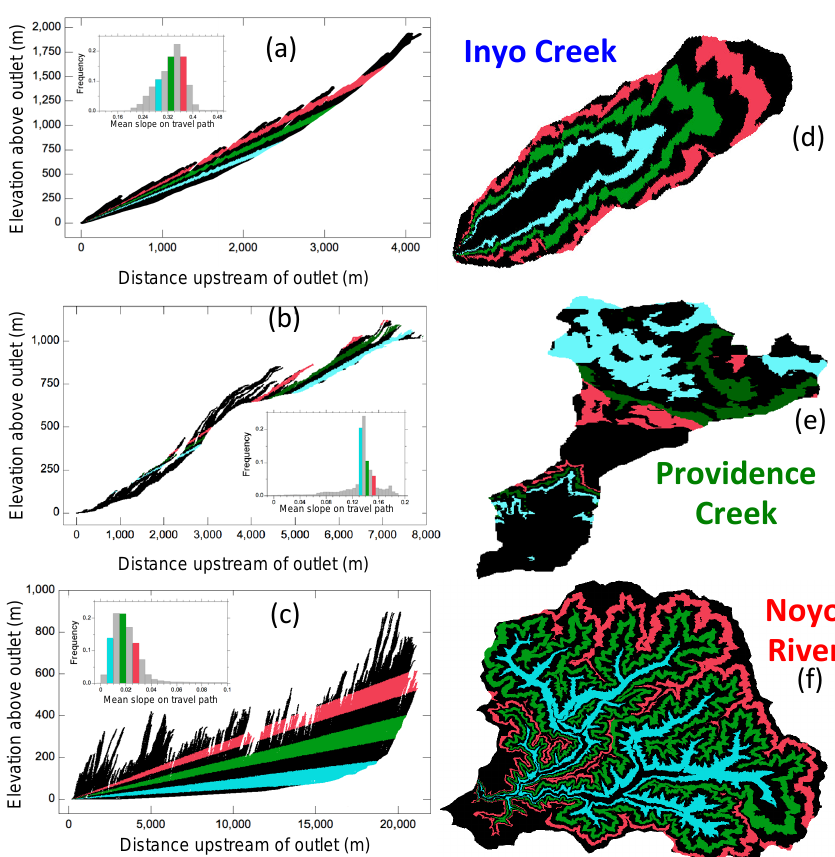
Figure 5. Distribution of mean slope across catchments. Histograms (insets, a–c ) of mean slope along travel path from source to outlet (ratio of source-area elevation to travel distance), with colors highlighting bins of relatively low, medium, and high values. Bins of common mean slope form linear bands on plots of elevation vs. travel distance ( a–c ). Maps of catchments ( d–f ) show spatial distribution of source areas sharing similar mean slope for highlighted